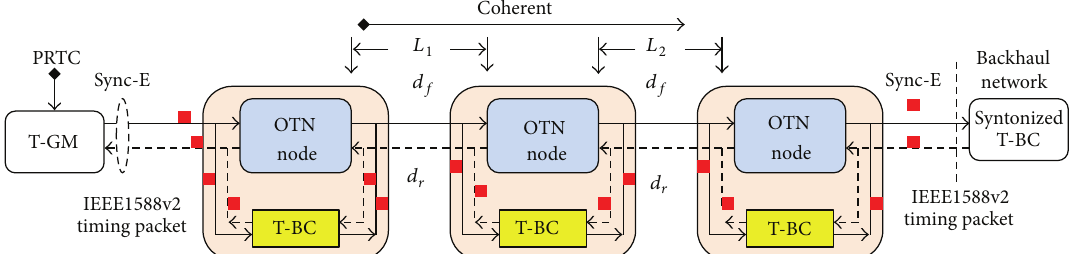
Figure 4: Telecom-Boundary clock mode in OTN.